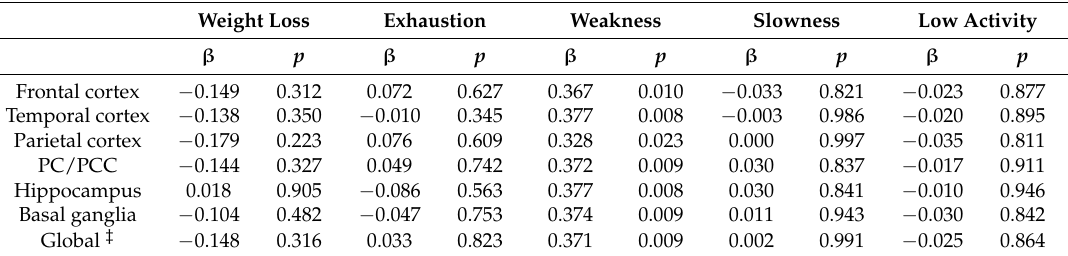
Table 3. Association between mean SUVR and frailty index criteria by brain